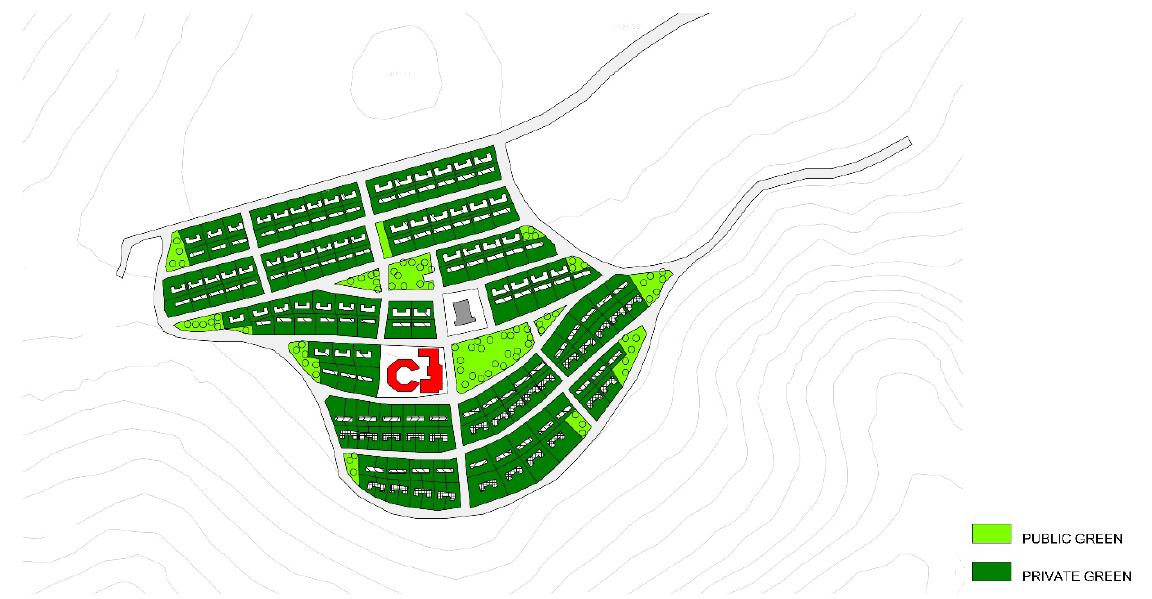
Figure 41. Public and private gardens in Kigali 2020 Settlement. Drawing by Manlio